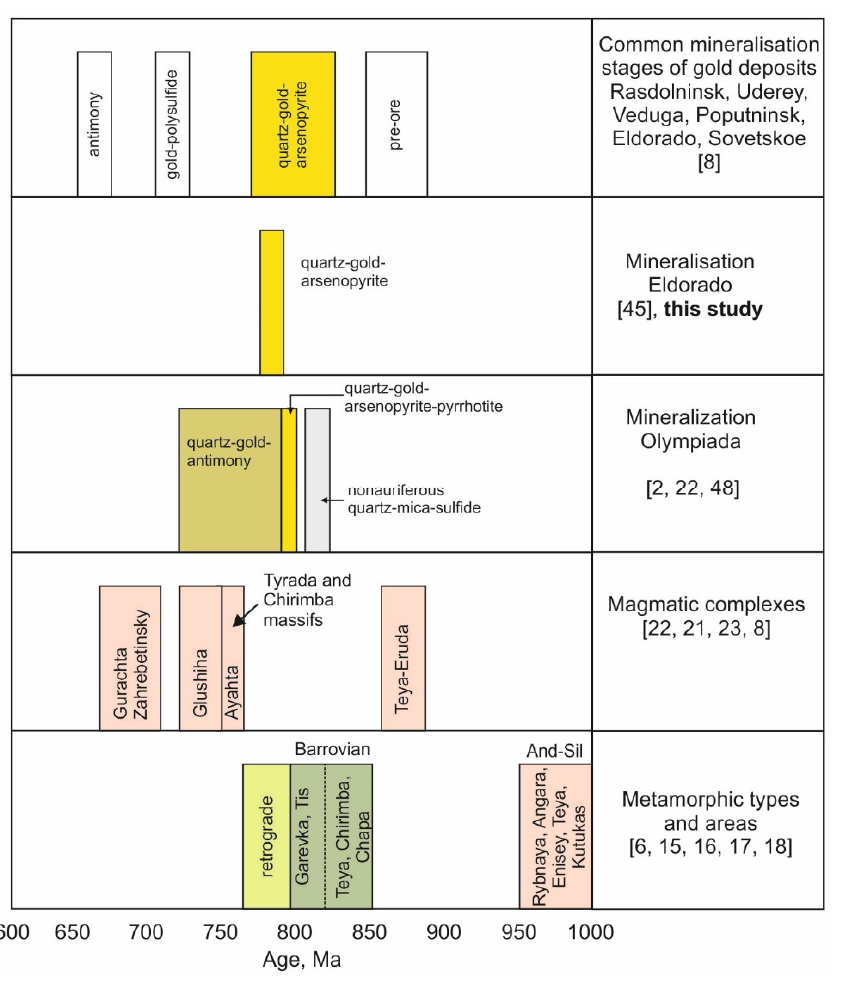
Figure 11. The time correlation scheme of main magmatic and metamorphic events with mineralization stages of gold deposits of the Yenisey Ridge.